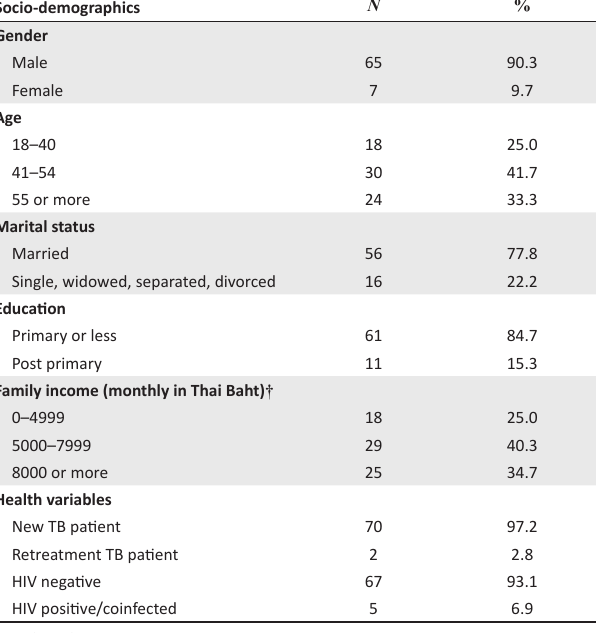
TABLE 1: Sample characteristics at 6 months of follow-up ( N = 72).